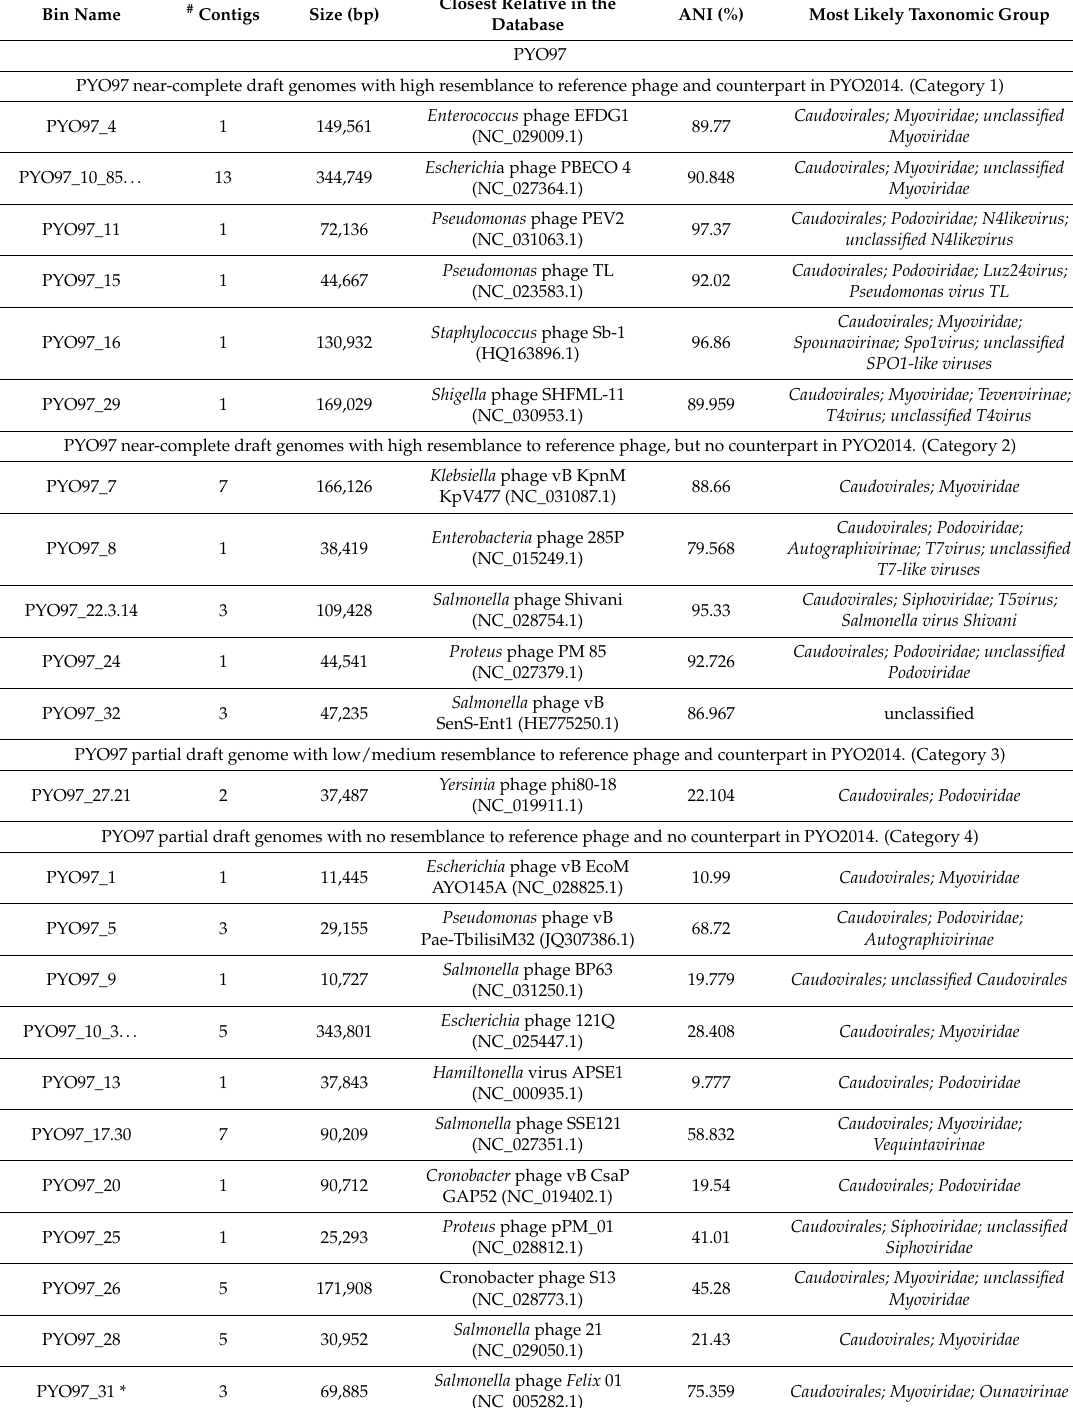
Table 8. Overview of the phage draft genomes and bins of PYO97 indicating the most likely taxonomic group they belong to. PYO97_10_85 . . . and PYO97_10_3... correspond